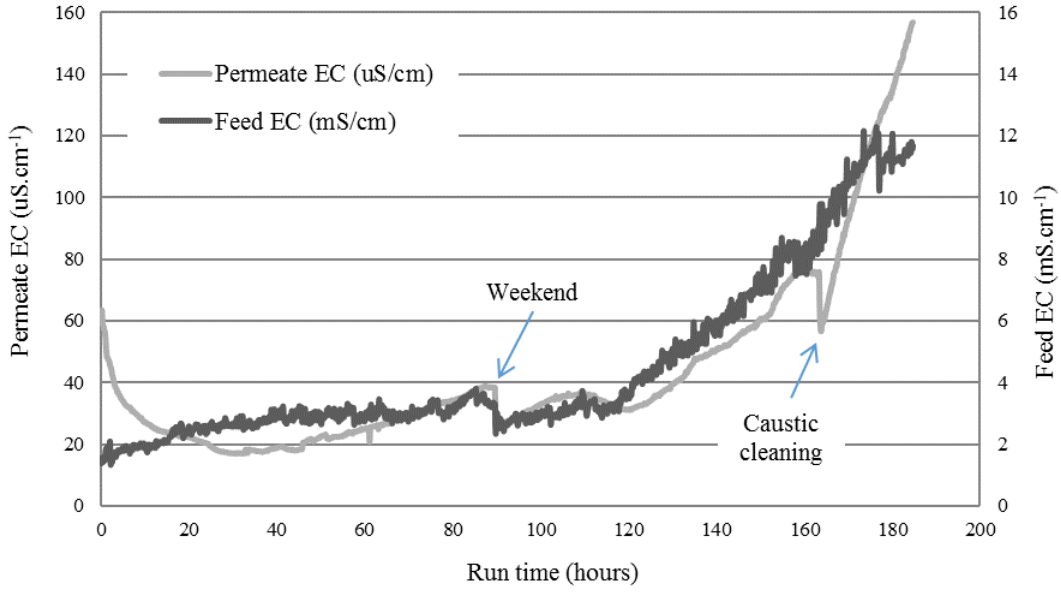
Figure 5. EC of the feed and permeate cycle containers while treating the textile wastewater on the hydrophobic membrane.